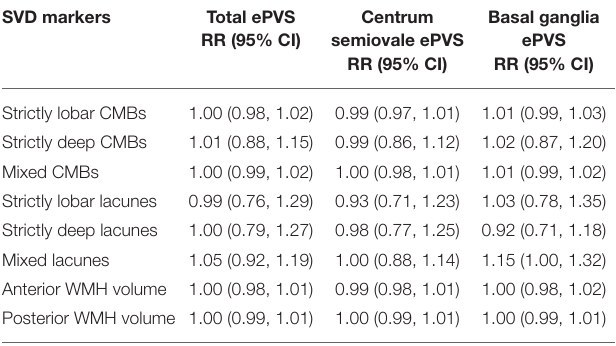
TABLE 3 | Association between location of SVD and ePVS (Memory clinic).